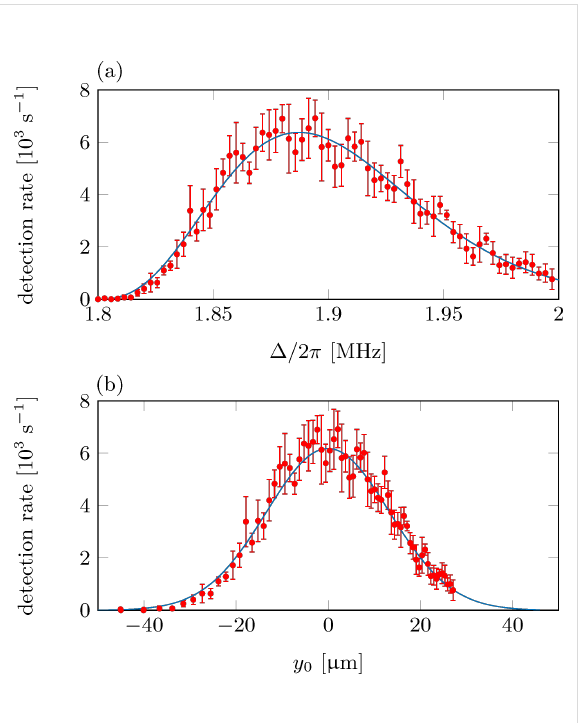
Figure 7: (a) Detection rate as function of the microwave detuning (spectral response), averaged over three measurements. For each measurement the microwave has been swept with a rate of 286 kHz/s, while monitoring the corresponding ionization rate. The microwave detuning is shown with respect to the zero-field transition frequency of ≈ 6.8 GHz between the rubidium hyperfine ground states. Each micro- wave frequency addresses a specific outcoupling plane at position y 0 . (b) Detection rate as function of y 0 .